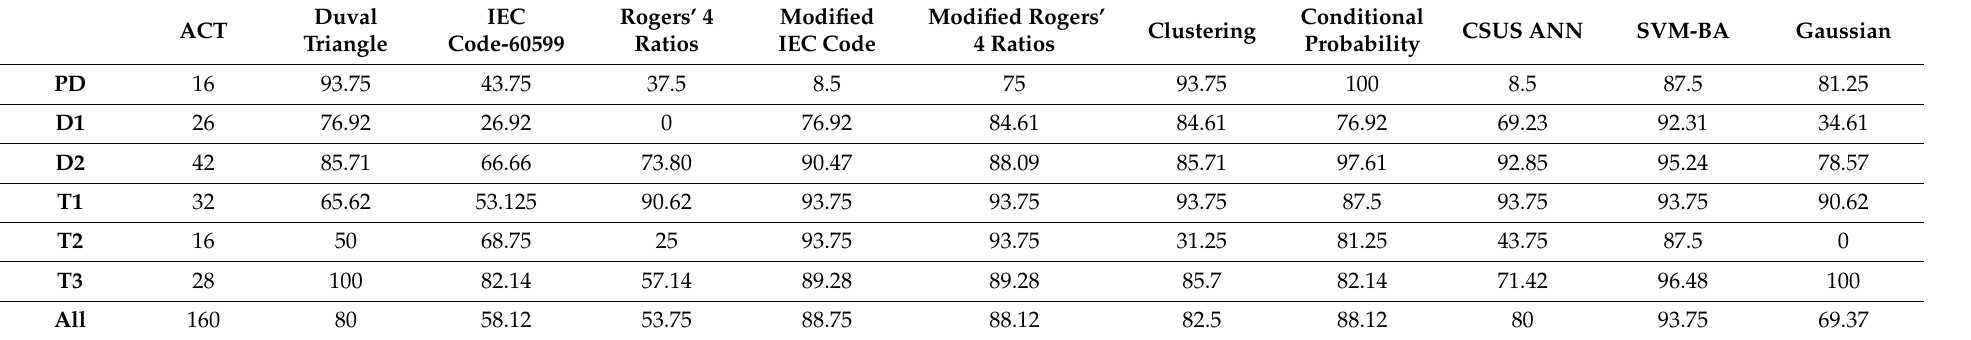
Table 5. Accuracy rate table of different